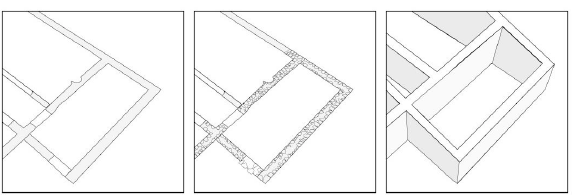
Figure 2. Reconstruction of the the geometric